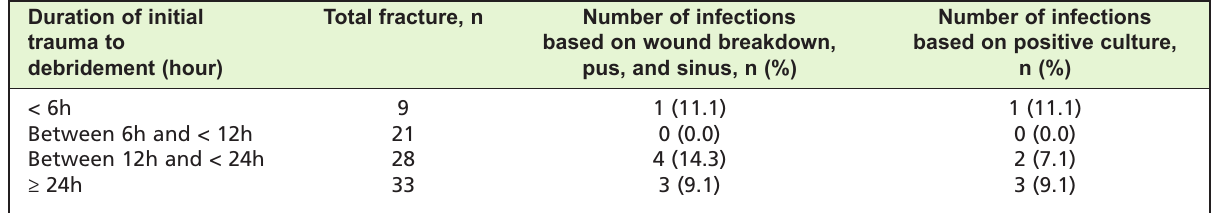
Table III: Rate of infection per time group